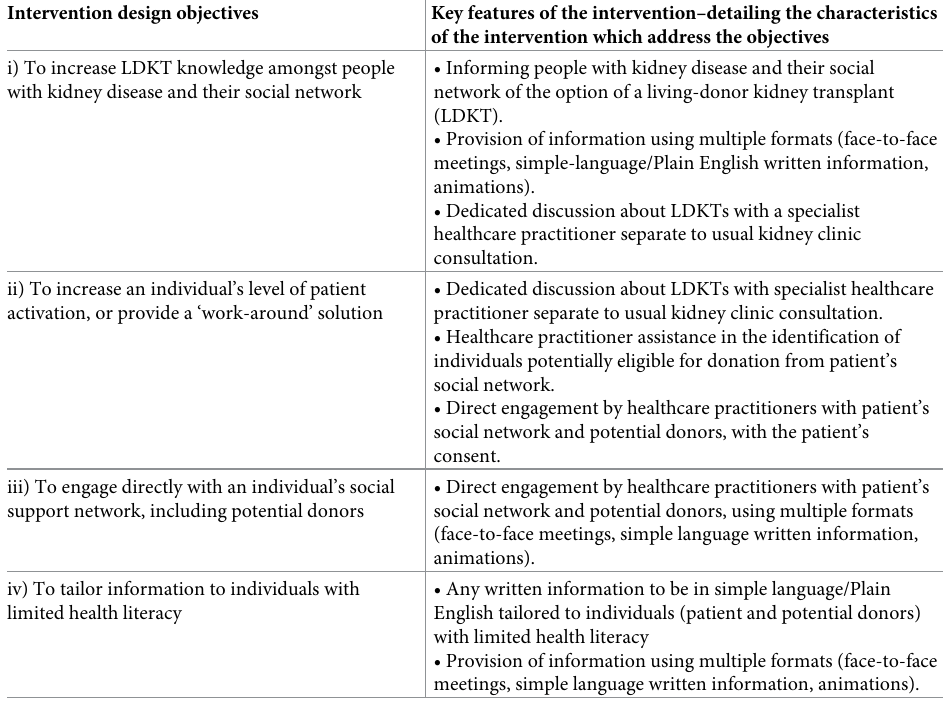
Table 2. Guiding Principles for intervention development: Intervention design objectives and key features of the intervention that can achieve these objectives. Intervention design